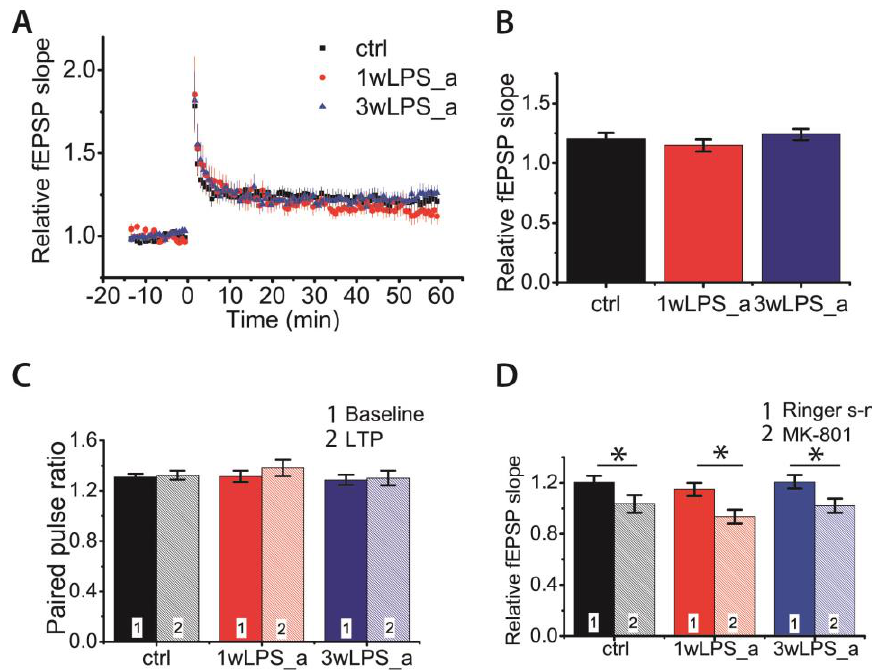
Figure 7. LTP properties are not disturbed in adolescent rats administered with LPS during the first postnatal week (1wLPS_a) or third postnatal week (3wLPS_a). ( A ) Diagram showing the normalized slope of fEPSP in the control (ctrl) and experimental groups (1wLPS_a and 3wLPS_a) before and after TBS. ( B ) Diagram illustrating average LTP values in these groups. One-way ANOVA: F 2;48 = 0.27; p = 0.77. ( C ) Diagram showing the PPRs of fEPSPs before (baseline) and after (LTP) TBS in di ff erent groups. ( D ) Diagram illustrating the e ff ect of MK-801 (10 µ M) on LTP magnitude in the control (ctrl) and experimental (1wLPS_a; 3wLPS_a) groups * p <